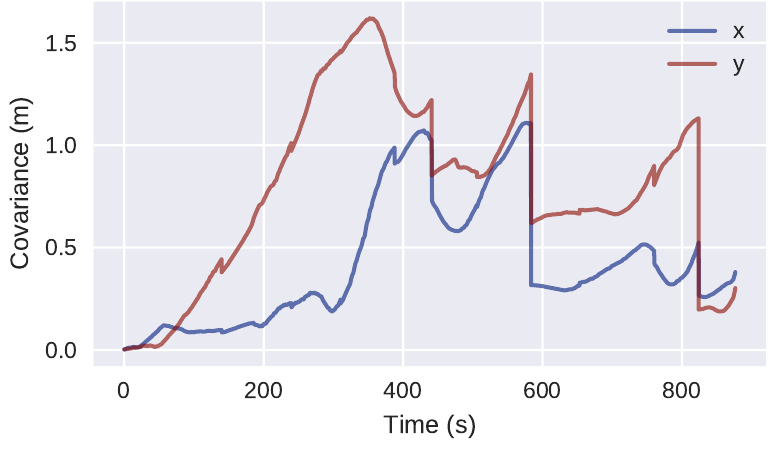
Figure 18. Covariance of the particles over time for the Breakwater dataset.